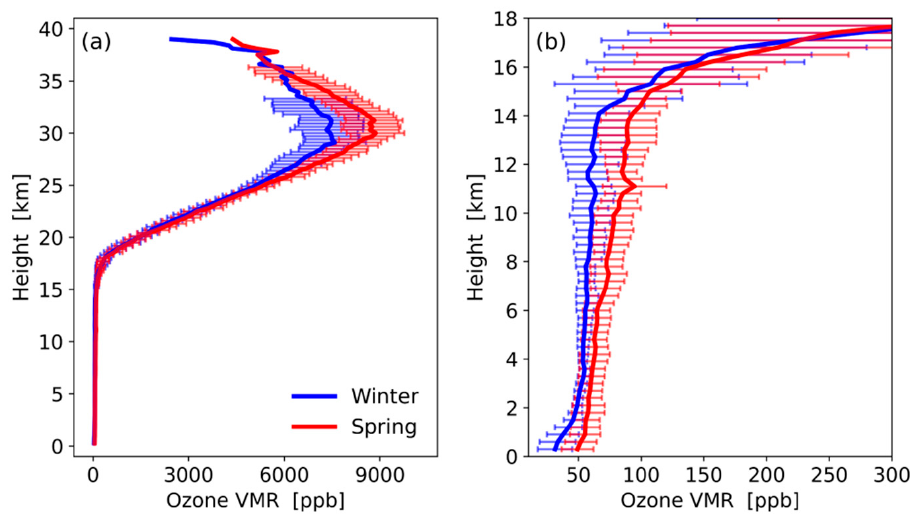
Figure 5. Same as Figure 4, but for OVMR.